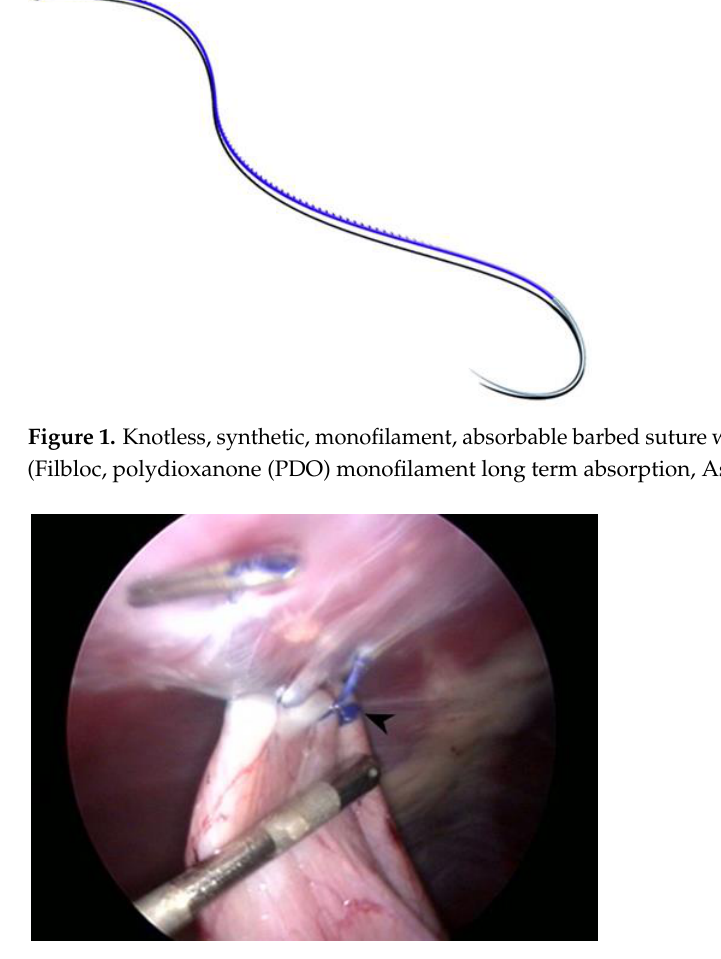
Figure 2. Laparoscopic image at the end of the gastropexy procedure while measuring the suture length. Note the button at the beginning of the suture (arrowhead) and the endoclip at the opposite end.